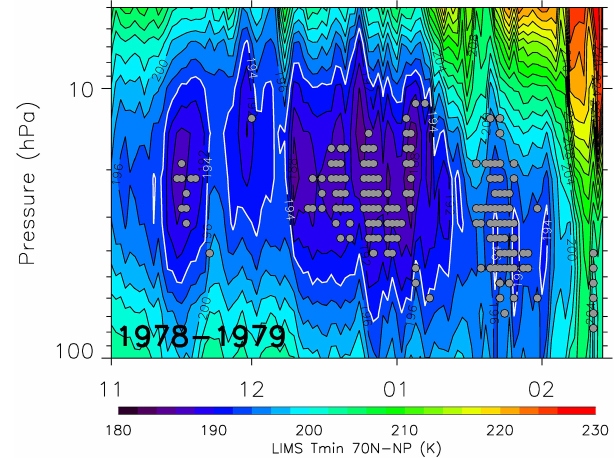
Figure 9. Daily time series of minimum V6 temperatures vs. pres- sure for the latitude zone of 70 ◦ N to the pole, plus locations of tops of PSCs (gray circles). Contour increment is 2K and the white con- tour is 194K. The abscissa is from 15 November through 28 Febru-